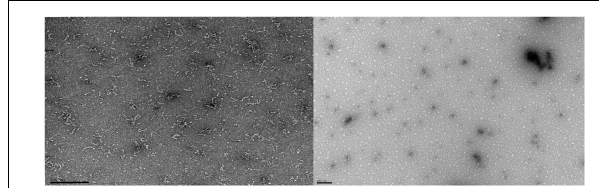
FIGURE 3 | Transmission electron microscopy analysis of the resveratrol effect on A β 1 - 42 aggregation. The A β 1 - 42 concentration was 25 µ M and the resveratrol concentration was 80 µ M. The samples were incubated at 37 ◦ C in phosphate buffered saline buffer. The left side of the figure represents the incubation of A β 1 - 42 without RES, and the right side shows A β 1 - 42 incubated with RES. As shown in the figure RES prevented the formation of amyloid fibrils. The scale bar corresponds to 200